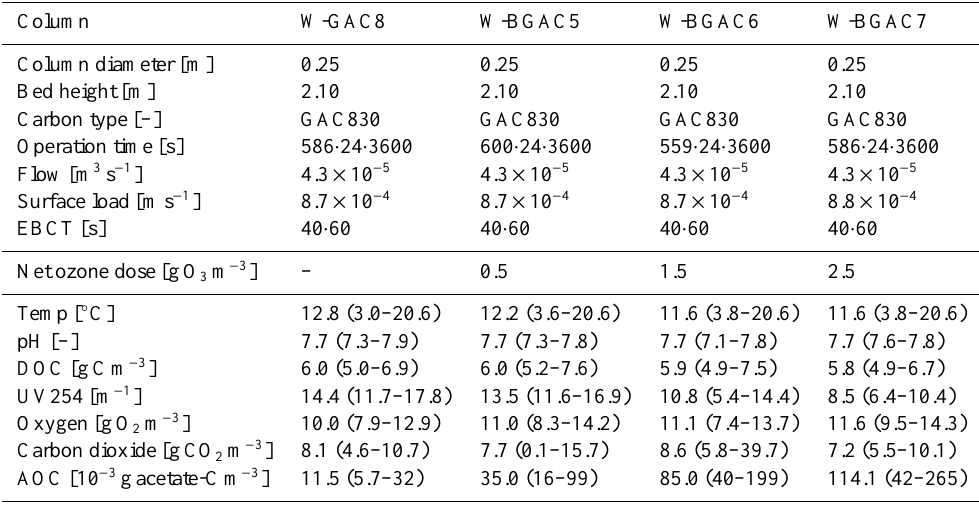
Table 1. Characteristics and influent water qualities pilot plant Weesperkarpsel.